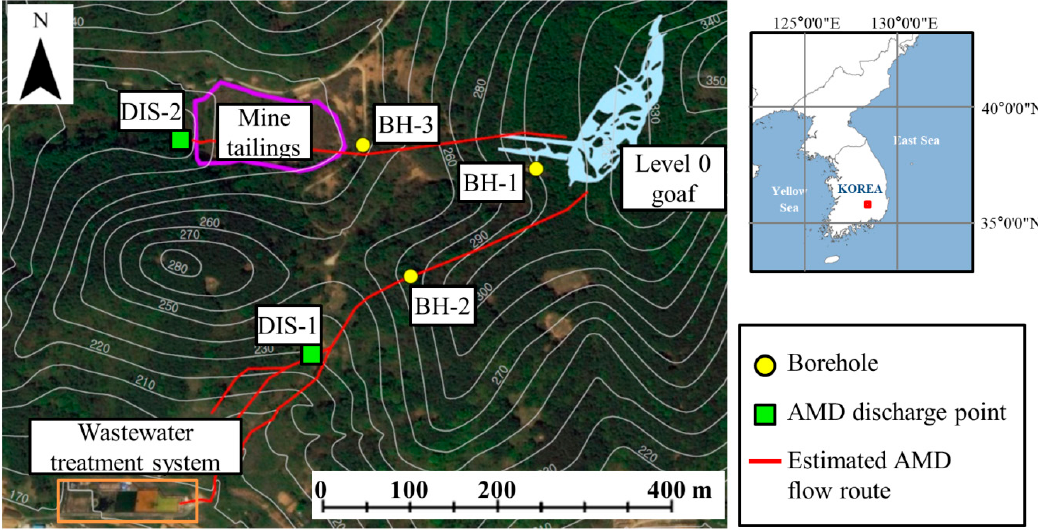
Figure 10. Mine maps of the Dalsung copper mine.